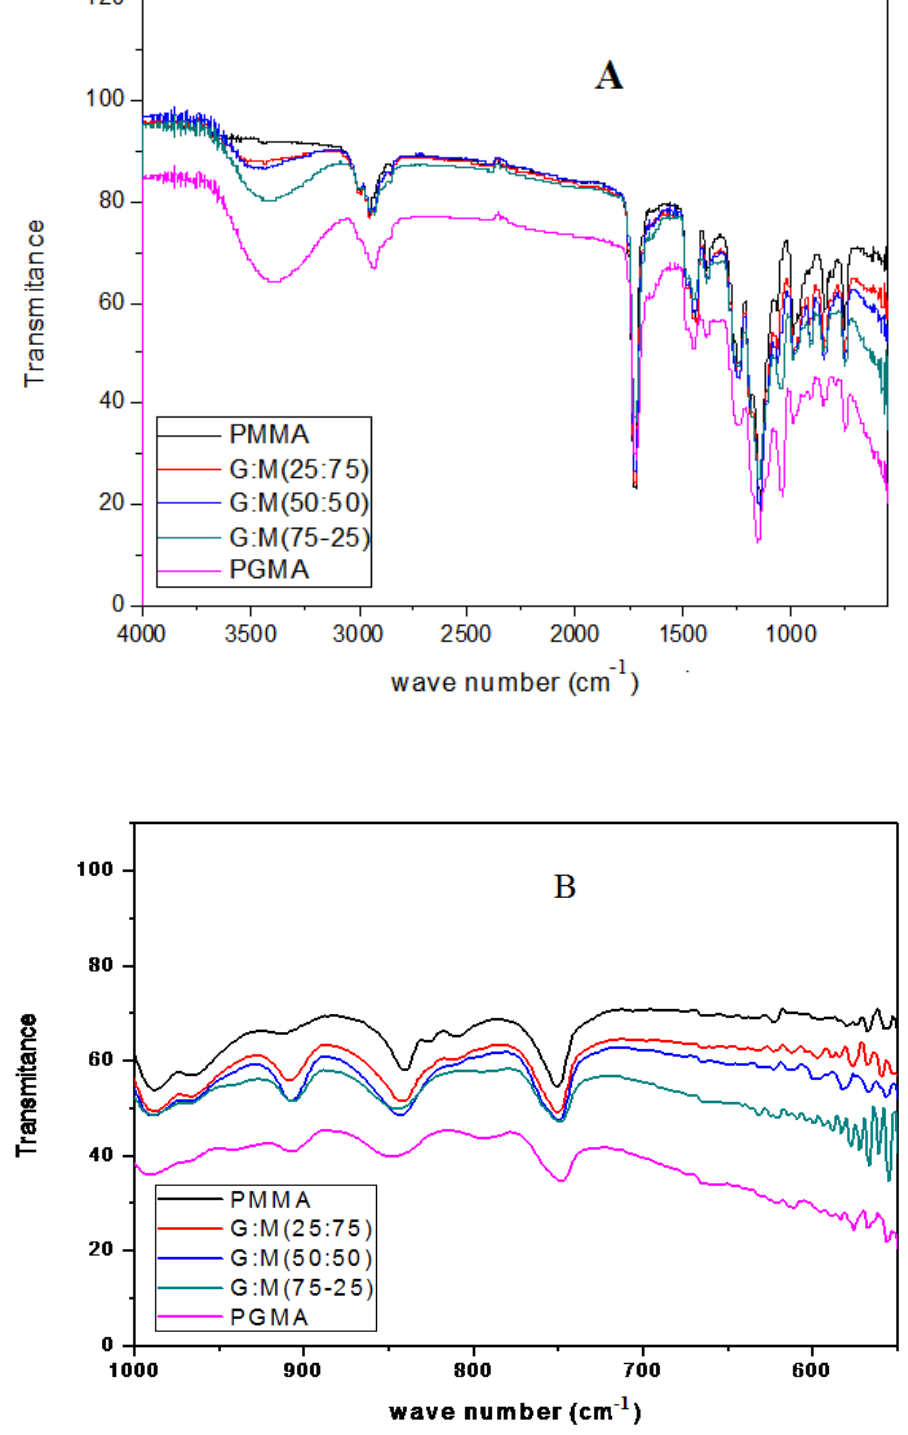
Figure 8. FT-IR spectra of PMMA, SPGMA-co-PMMA copolymers, and SPGMA; ( A ) 400-4000 cm − 1 , and ( B ) 400-1000 cm − 1 .